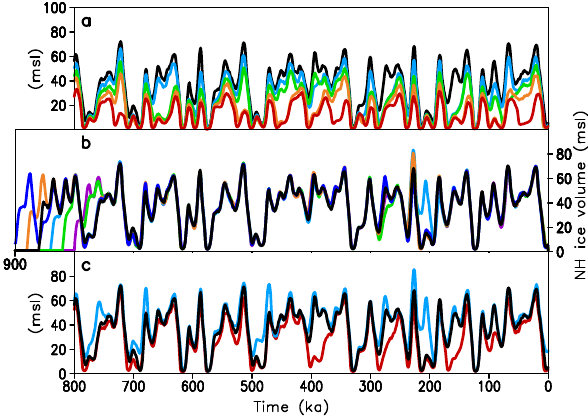
Fig. 6. Robustness of simulated glacial cycles. (a) Simulated NH ice volume variations in the experiments CC n (constant CO 2 ). The colours indicate the CO 2 levels: 200ppm (black), 220ppm (blue), 240ppm (green), 260ppm (orange), 280ppm (red). (b) Simulated NH ice volume variations in the experiments CC200/ m starting from identical (interglacial) initial conditions but at a different time: m =900kyrBP (purple), m =880kyrBP (orange), m =860 (black), m =840 (light blue), m =820 (green) and m =800 (violet) kyrBP. (c) Simulated NH ice volume variations in experiment CC200 with the standard glaciogenic parameterization (black), doubled (red) and halved (blue) glaciogenic dust deposition